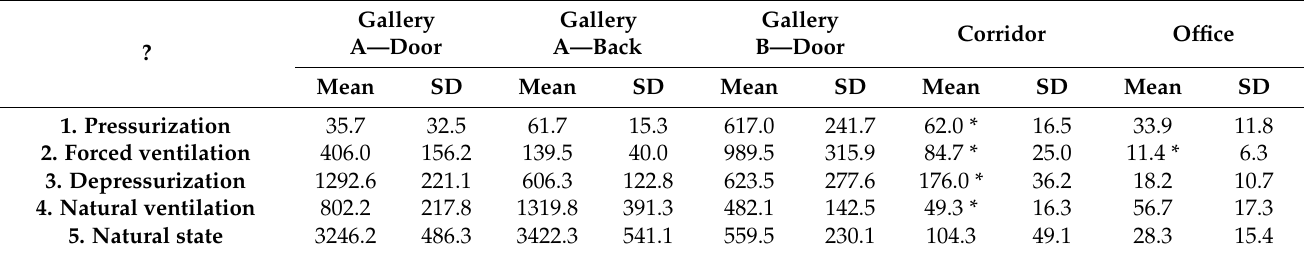
Table 3. Summary of radon levels (Bq/m 3 ) achieved with mitigation